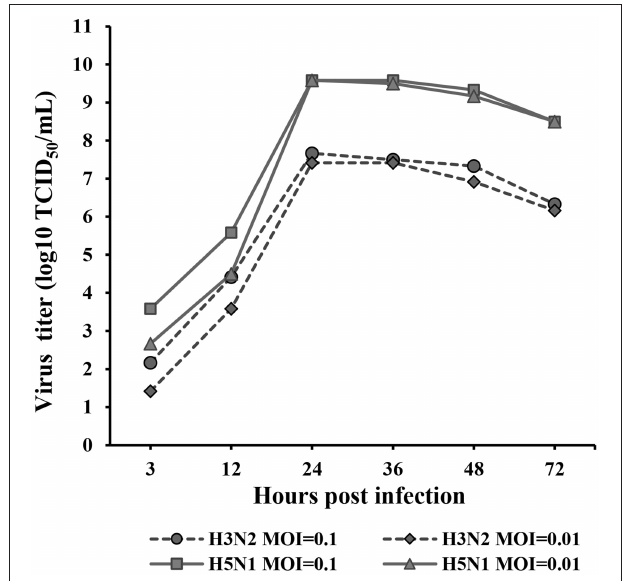
FIGURE 1 | Replication kinetics of H3N2 and H5N1 in MDCK cells. Monolayers of MDCK cells were infected with each virus at MOIs of 0.1 and 0.01. Virus titers were determined using the TCID 50 assay at 3, 12, 24, 36, 48, and 72 hpi. TPCK-trypsin (0.25 mg/mL) was added to the medium to promote the propagation of the H3N2 influenza A virus. The data were analyzed using one-way ANOVA ( p < 0.05). Data are presented as the means ± SD of independent triplicate